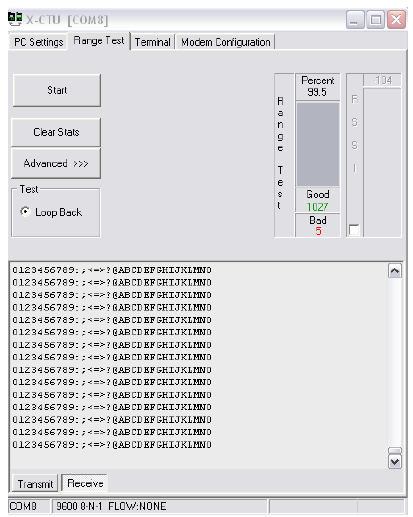
Figure 13. Range test with the X-CTU